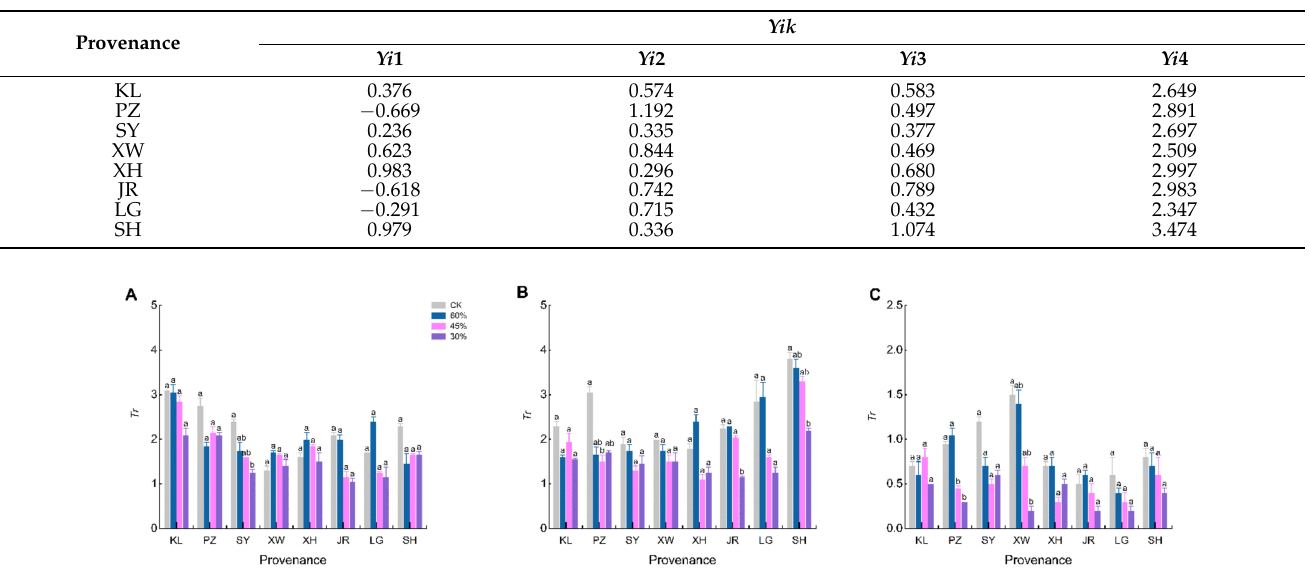
Figure A1. The transpiration rate of Melia azedarach among the different provenances: ( A ): early stage, ( B ): middle stage, and ( C ): late stage. Note: The error line in the figure is the mean ± standard error, and different lowercase letters in the same provenance indicate significant differences at the 0.05 level, as in the following figures.